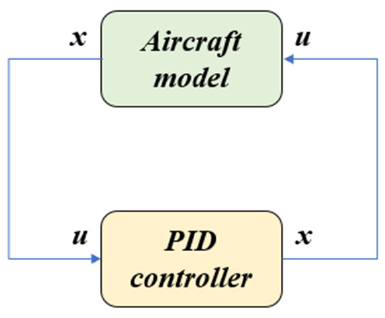
Figure 19. The flight control model.